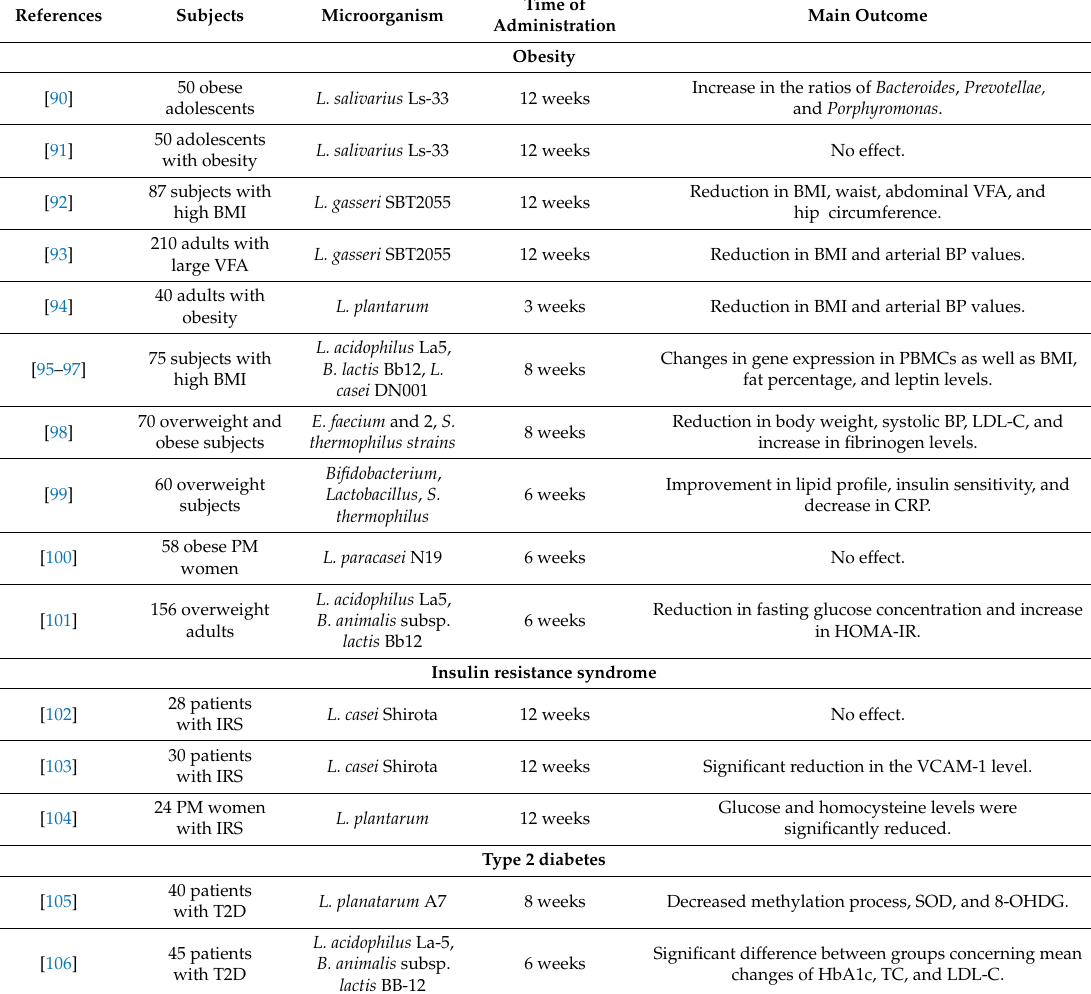
Table 3. Examples of clinical trials regarding the effect of probiotics on human